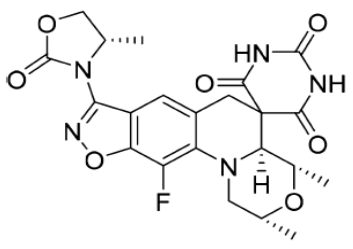
Figure 1. Formula of zoliflodacin.